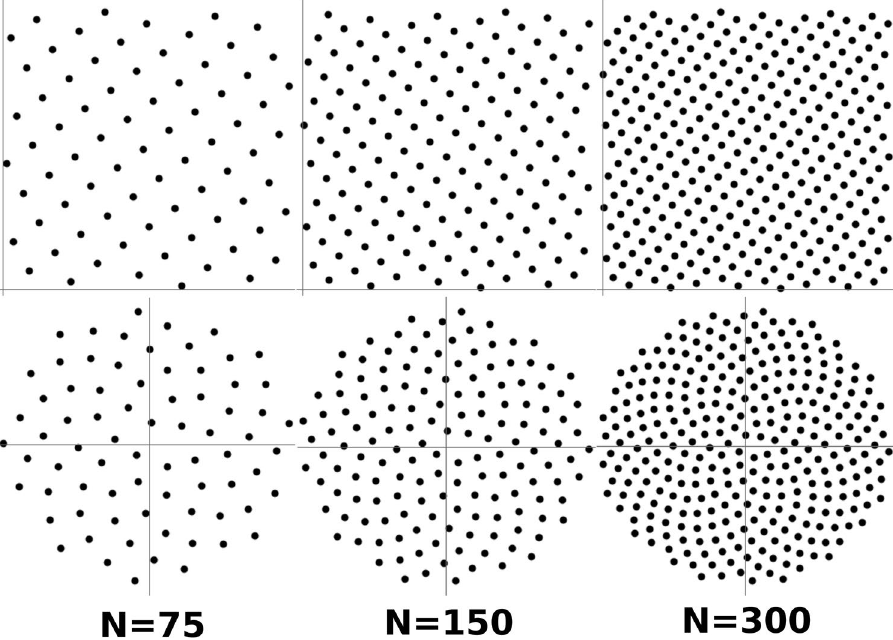
Figure 6. Top row shows the Fibonacci lattice in the unit rectangle for n=75, 150 and 300 points respectively, from left to right. On the bottom row we see the Fibonacci spirals, the mapping of the lattice into polar coordinates in the unit